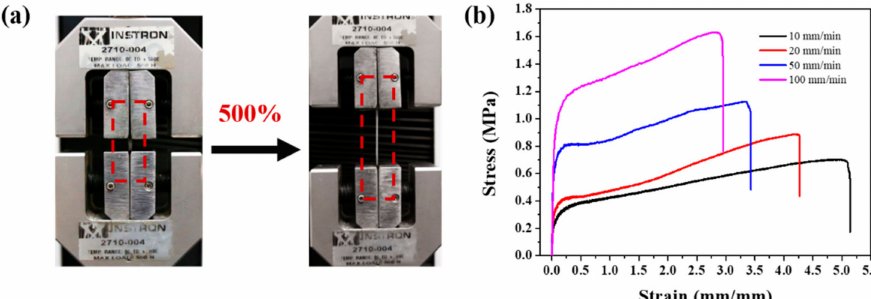
Figure 3. ( a ) Optical images showing the PDMS-COO-E polymer films at 0% (left) and 500% strains (right), respectively. ( b ) Stress–strain curves of the PDMS-COO-E samples with di ff erent stretch speeds range 10 to 100 mm min –1 at 25 ◦